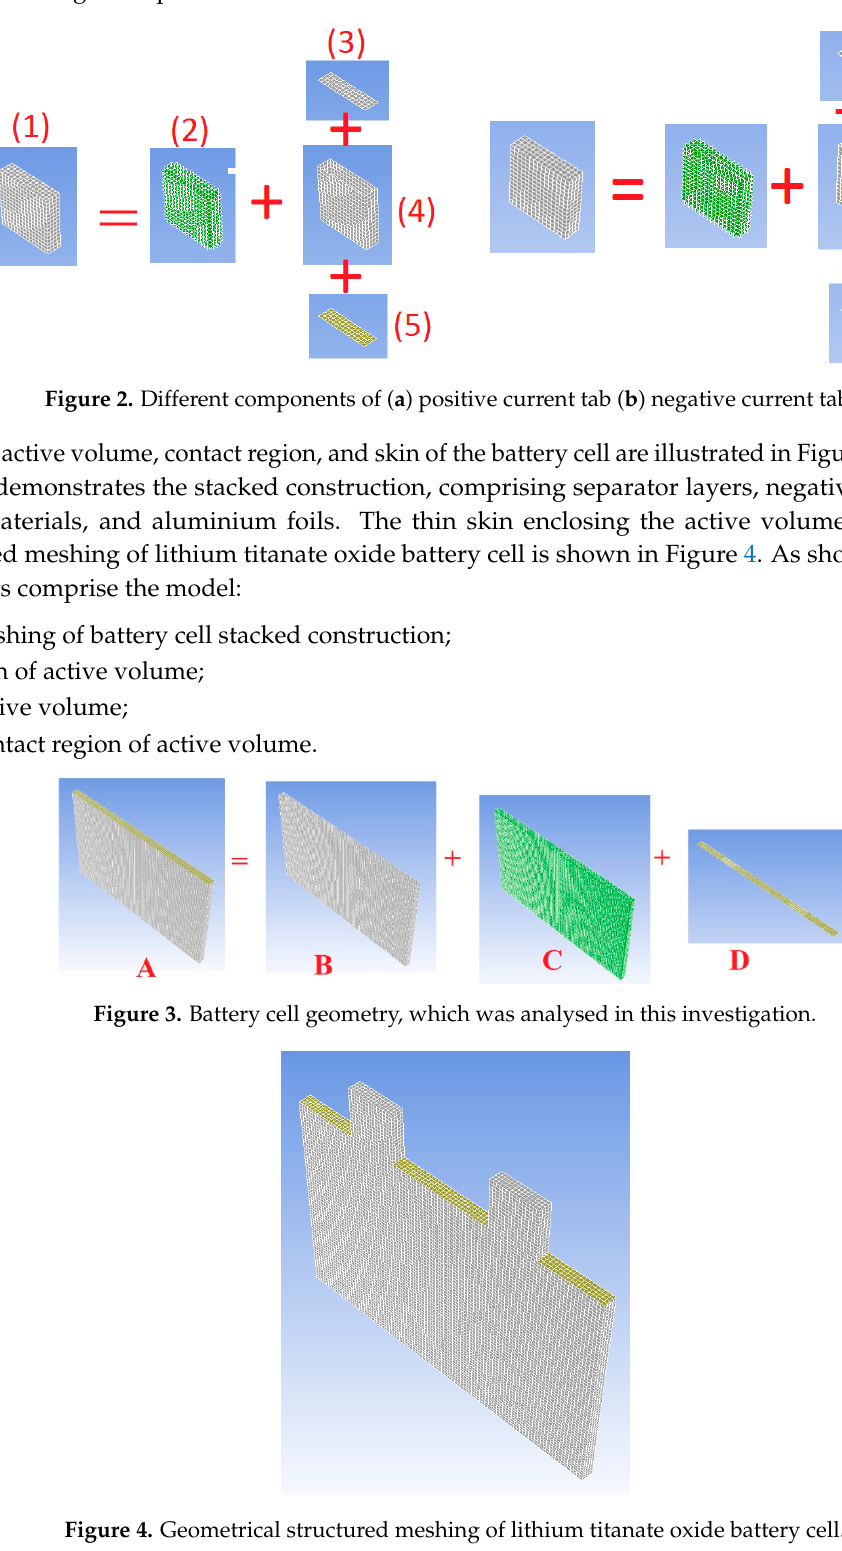
Figure 4. Geometrical structured meshing of lithium titanate oxide battery cell.